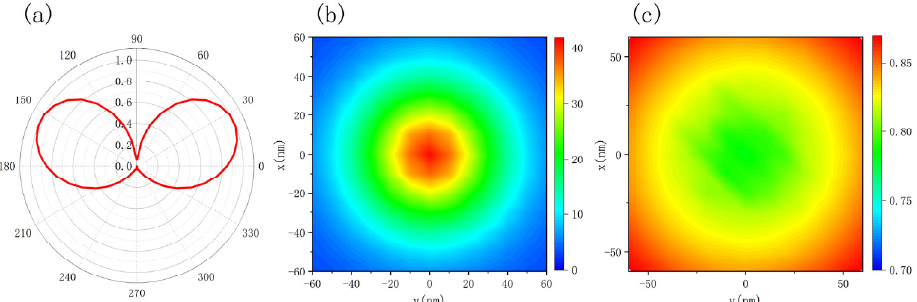
Figure 3. ( a ) Spontaneous emission angular distribution, ( b ) spontaneous emission enhancement distribution diagram, and ( c ) quantum yield distribution diagram when the radius of the hemisphere is 60 nm and the radiation wavelength is 650 nm.